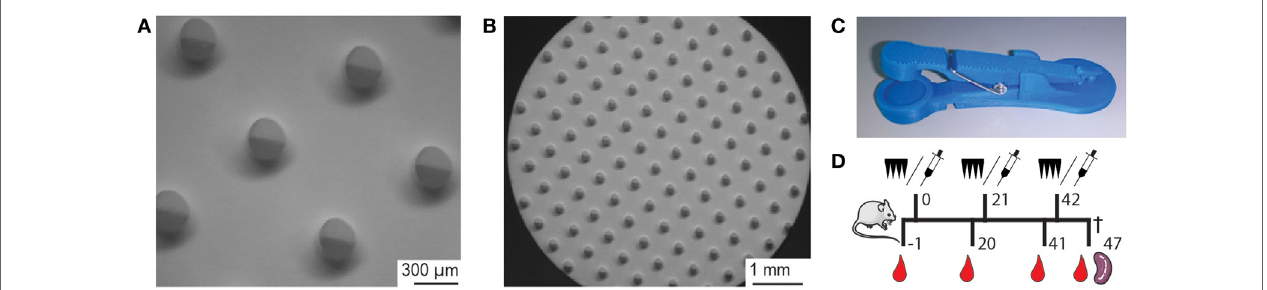
FigUre 1 | (a,B) Brightfield microscopy images of a nanoporous microneedle array (npMNA) from the needle-side with microneedles with a length of 475 µm and a density of 105 microneedles/array. (c) Microneedle applicator design that was used to apply npMNAs onto mouse ears. Upon lowering the applicator lid, a microneedle array is pierced into the skin by impact application, and the npMNA is subsequently held onto the skin by force (4 N). (D) Experimental setup for immunization studies. Immunization with either npMNA or hydrodermic needle on days 0, 21, and 42. Blood samples for serum were collected on days − 1, 20, 41, and 47, at which the experiment was terminated and subsequently, spleens were